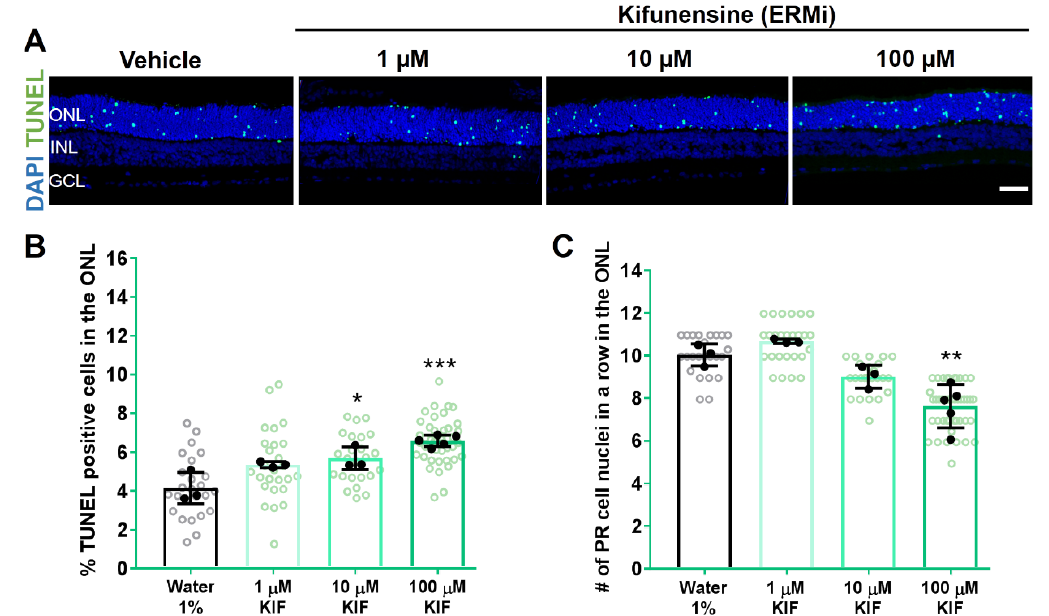
Figure 3. Pharmacological inhibition of ERM1 increases cell toxicity in photoreceptor cells in RHO P23H rats in vitro. Retinae from RHO P23H transgenic rats were explanted at postnatal day 9, cultivated for 6 days (PN9 DIV6), and treated every second day with different concentrations of the ERM1 inhibitor kifunensine (KIF) or vehicle control (water 1%). ( A ) Explants were stained with TUNEL assay to differentiate photoreceptors undergoing cell death (green) using nuclei counterstaining with DAPI (blue). ( B ) Bar chart shows the percentage of TUNEL-positive cells in the ONL. A significant increase in the percentage of dying cells was observed after the KIF treatment. ( C ) Comparison of the number of remaining photoreceptor cell nuclei in a row in the ONL. Retinae treated with 100 µM KIF showed a significant decrease in the number of photoreceptor cell rows. Scale bar is 50 µm. Values were quantified by scoring several images (open circles) from three retinae (closed circles, n = 3) per treatment for vehicle control, 1 and 10 µM KIF, and 5 retinae for 100 µM KIF (n = 5). The data are presented as mean ± SD, and one-way ANOVA analysis was performed. *** p < 0.001, ** p < 0.01, * p < 0.05. ERMi: